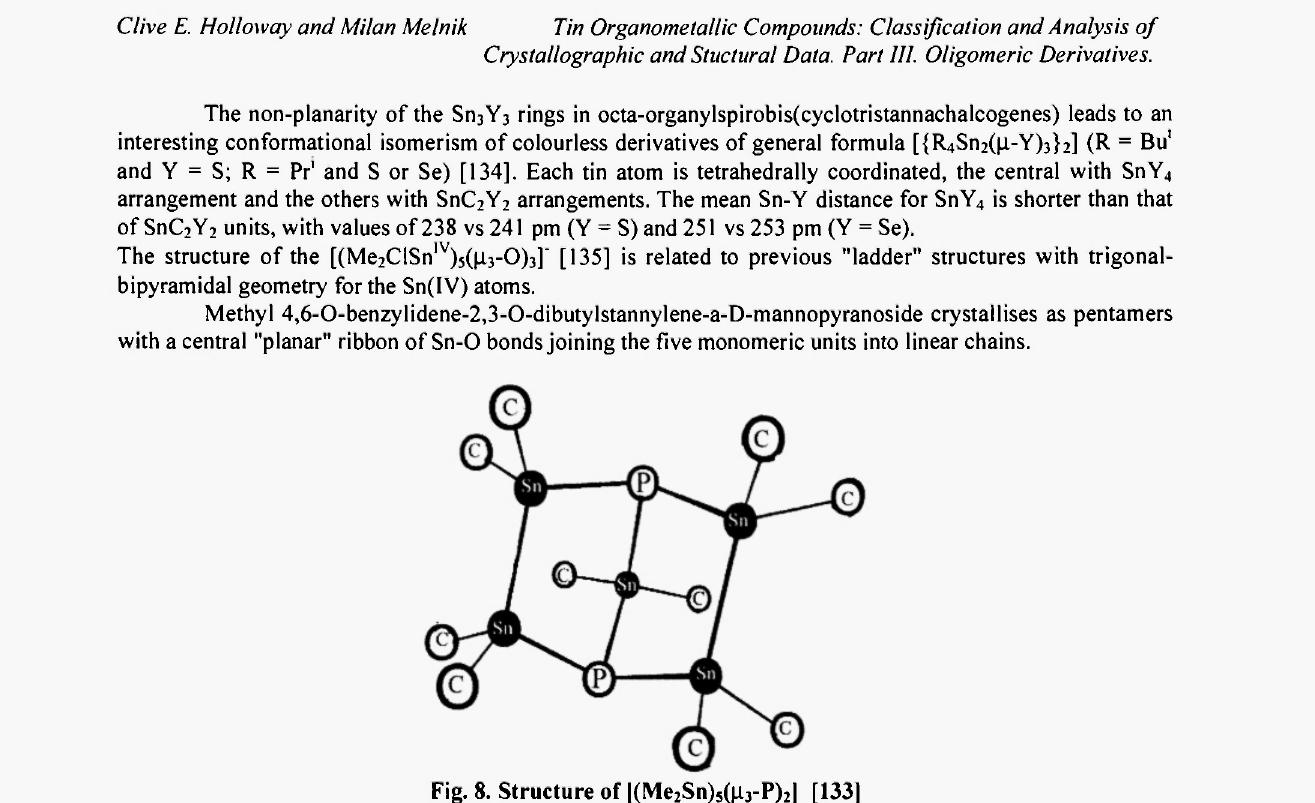
Fig. 8. Structure of [(Me 2 Sn ) 5 ^3 -P) 2 |